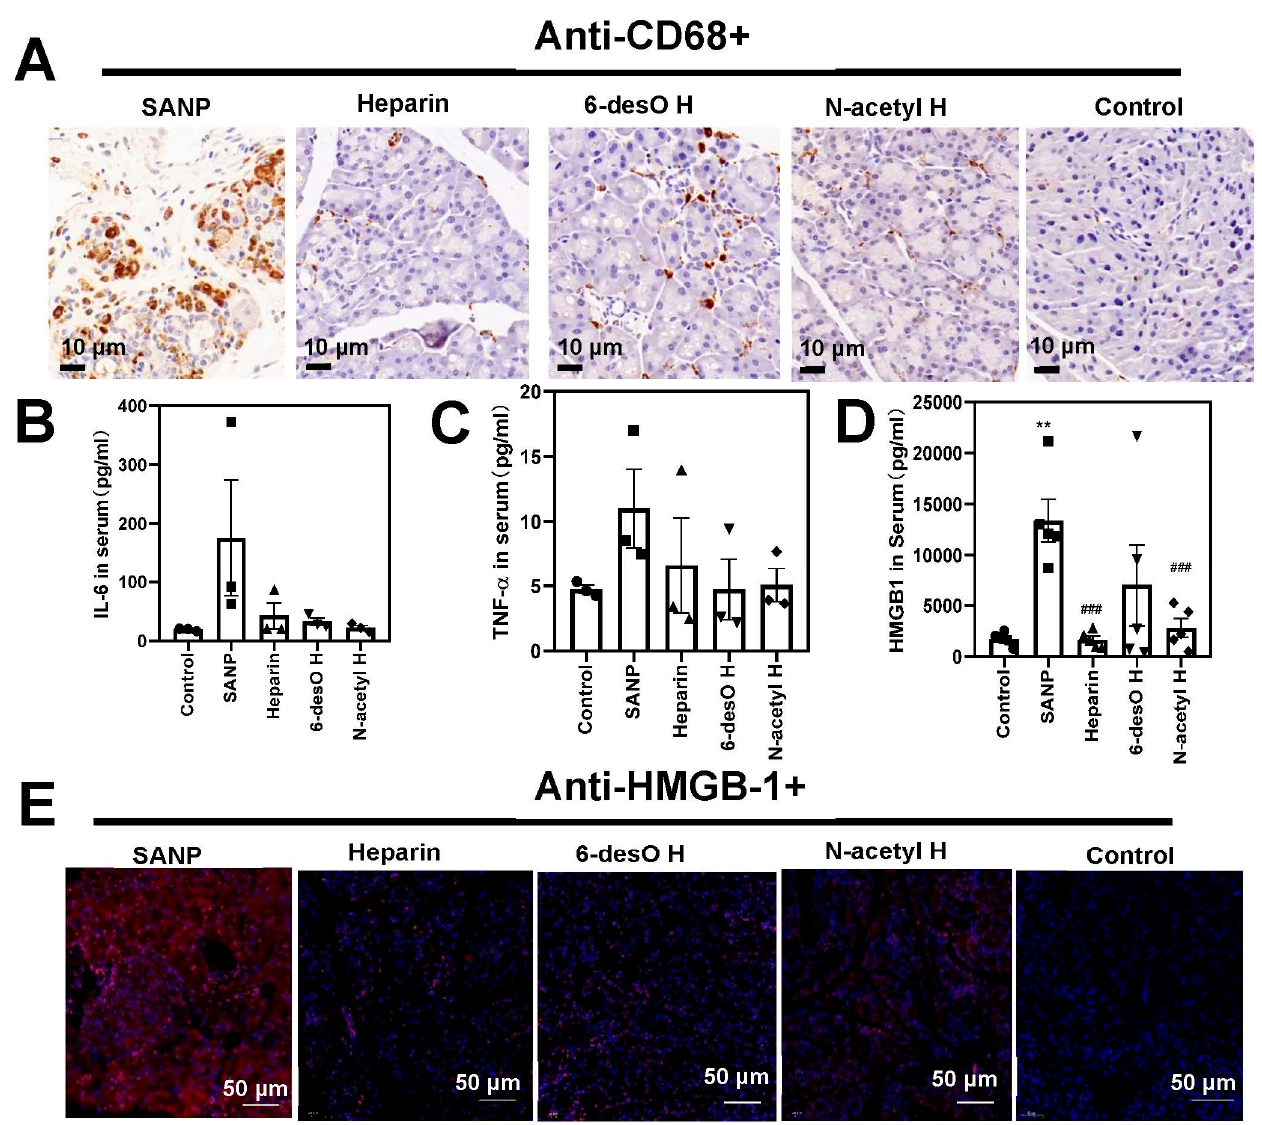
Figure 3. Heparin alleviated the high inflammatory conditions of SAP by reducing extracellular HMGB-1 levels. ( A ) The macrophages in the pancreas were labeled with anti-CD-68+ by immuno- chemical staining method. ( B – D ) The pro-inflammatory factors including TNF- α (B), IL-6 ( C ) and HMGB-1 ( D ) were analyzed in the serum by ELISA. ( E ) Extracellular HMGB-1 distribution assay in the pancreas by immunochemical staining (red for HMGB-1, and blue for DAPI; ### p < 0.001, SAP vs. other groups; ** p < 0.01, SAP vs. control groups).